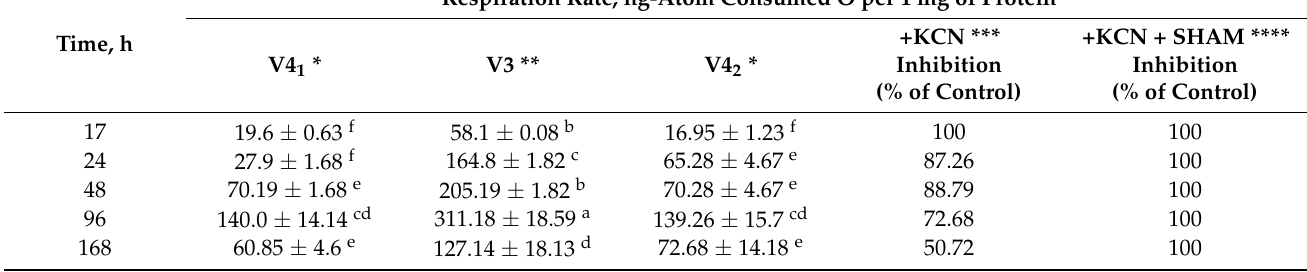
* V4 1 , V4 2 -the respiration rate in the second state (initial respiration) before and after the phosphorylation cycle. ** V3-the respiration rate in state 3 (the phosphorylation after the ADP addition). *** KCN was added in the concentration of 4 mM. **** SHAM was added in the concentration of 2 mM. The incubation medium for the experiments contained 0.6 M mannitol, 1 mM Tris-phosphate (pH 7.4); 1 mM EDTA, 20 mM pyruvate, 5 mM malate, and mitochondria corresponding to 0.4 mg protein/mL. a–f Means with the same letter did not differ significantly. Values are mean ± S.E.M from five independent experiments and three analytical